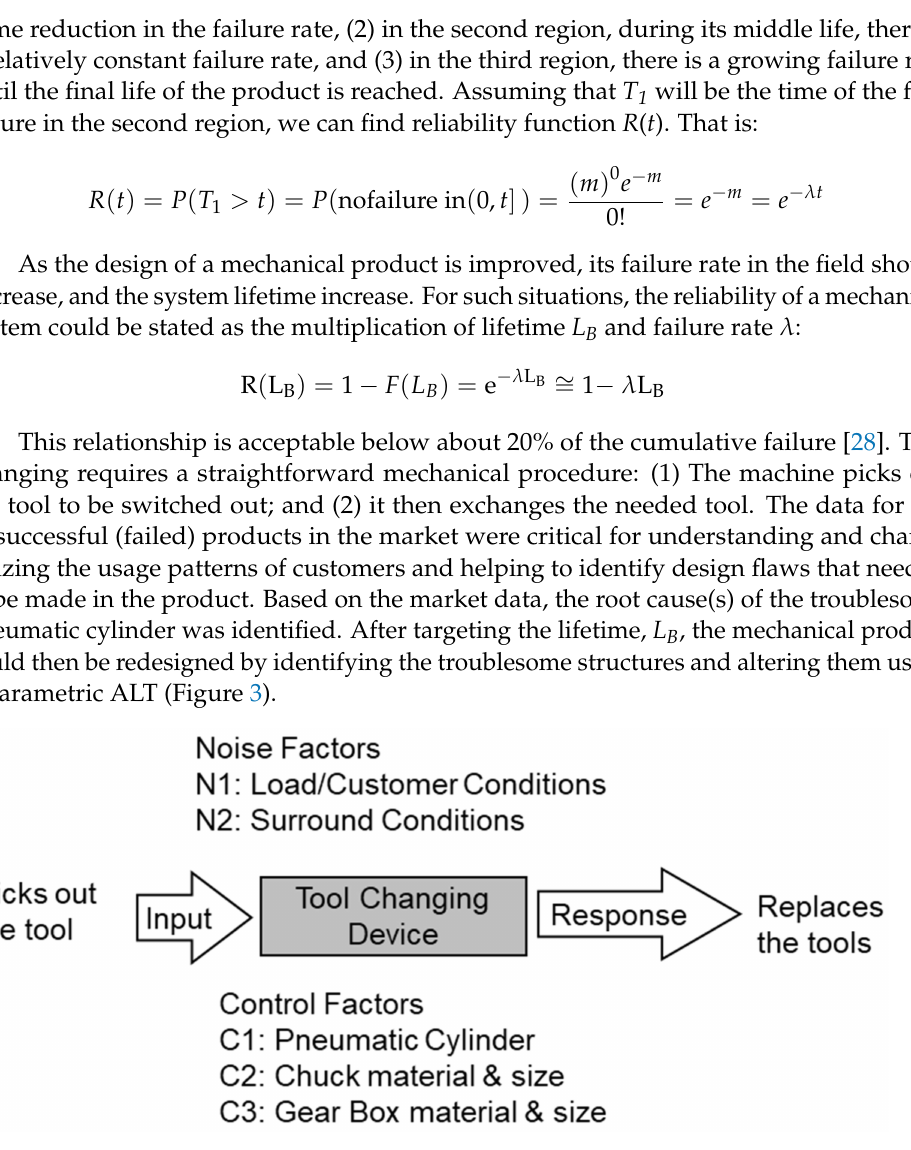
Figure 3. Intended function of tool change device including pneumatic cylinder